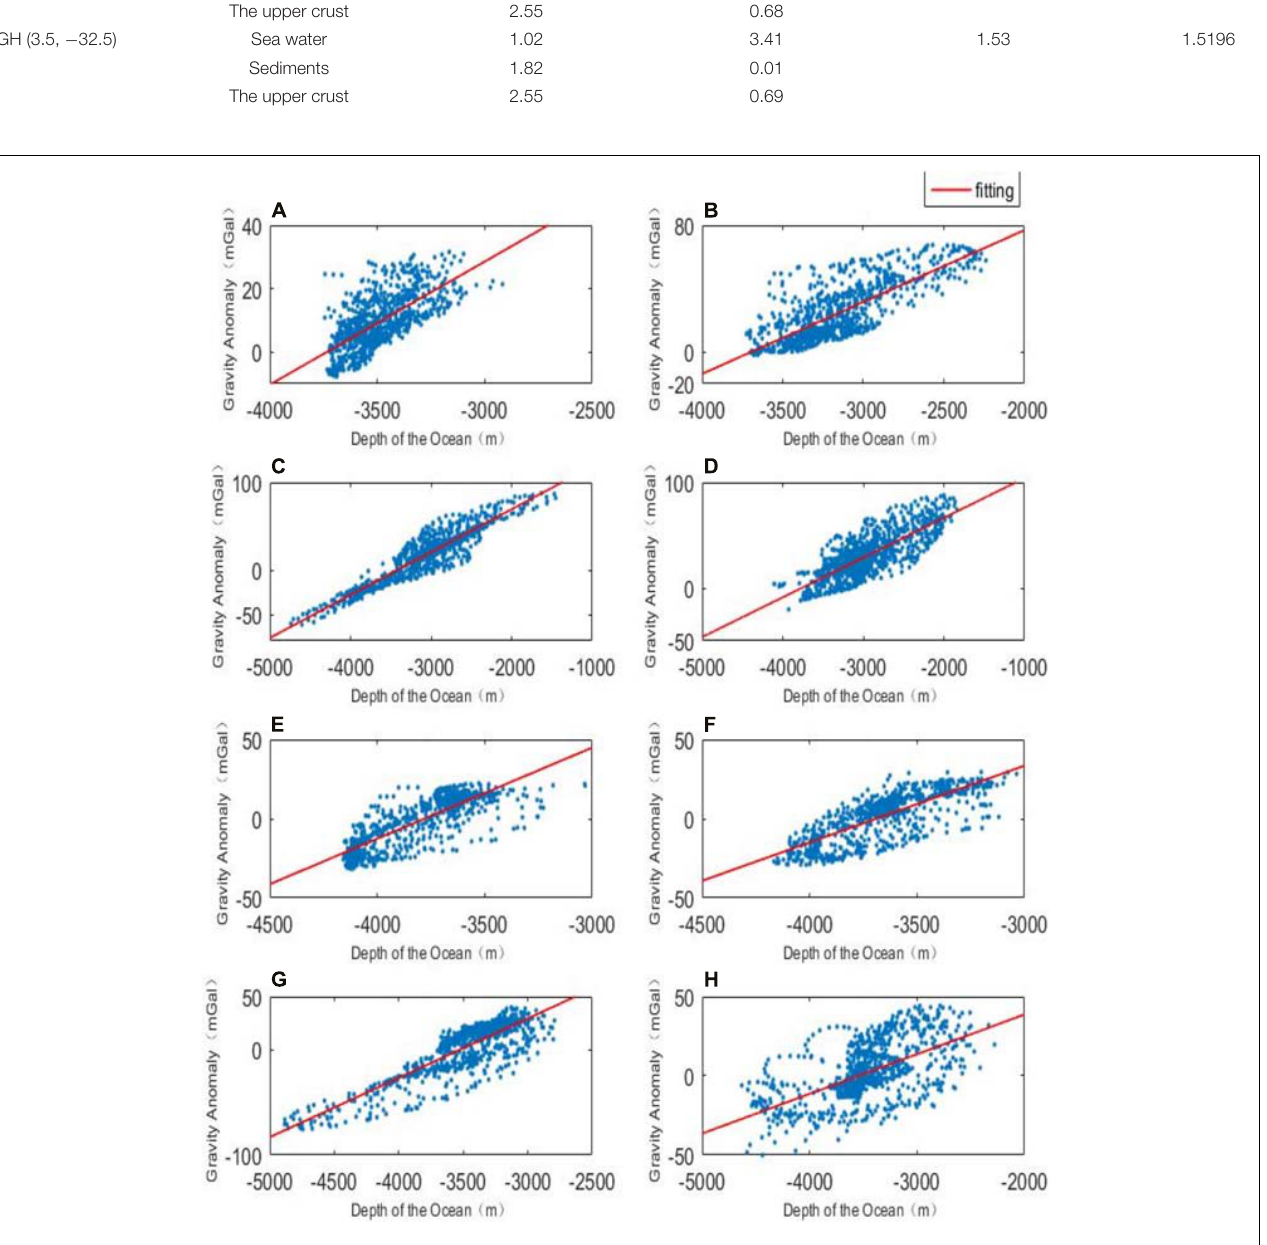
FIGURE 3 | Lines of fit for each region. (A–H) represent the related regions defined in Figure 1 .